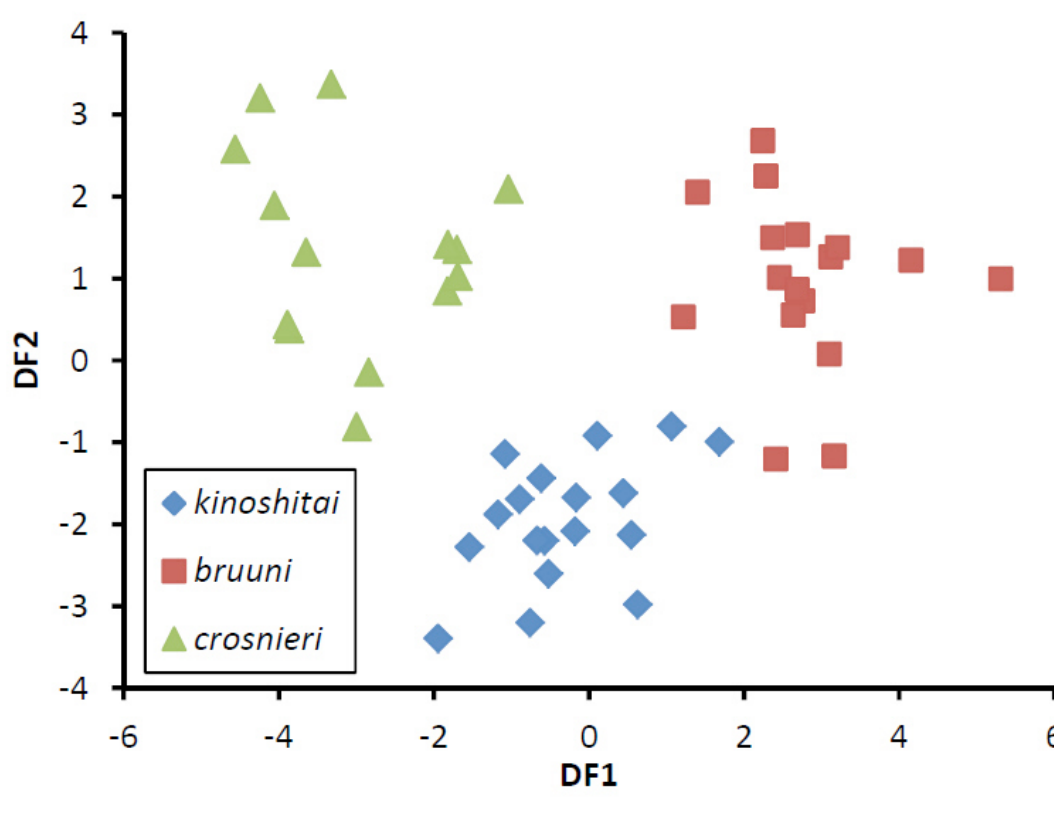
Fig. 7. 2D Scatter plot of the discriminant function analysis (DFA) for the species A. kinoshitai (Kuroda, 1956), A. bruuni (Powell, 1958) and A. crosnieri sp. nov. The analysis was performed using shell length (S ) and the shell morphometric parameters MD, HMD and SH as variables, and species hypotheses as L factor. Both DF1 and DF2 are statistically significant at the 95% probability level (DF1: 69.9 % relative percent, Wilks lambda = 0.0449, χ 2 = 138.085, df = 8, p = 0.0000; DF2: 30.1 % relative percent, Wilks lambda = 0.2946, χ 2 = 54.38, df = 3, p =